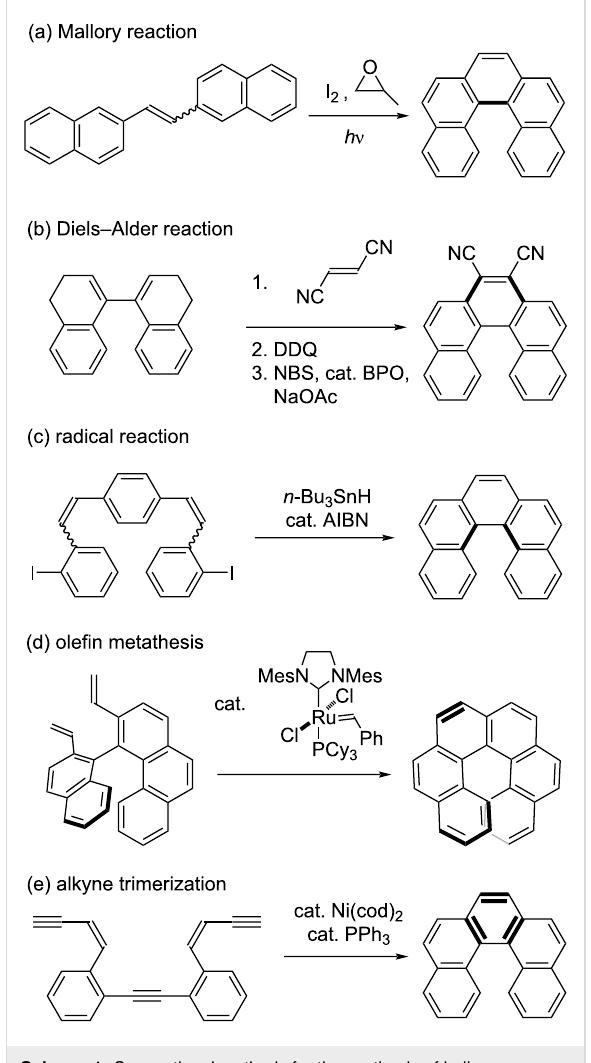
Scheme 1: Conventional methods for the synthesis of